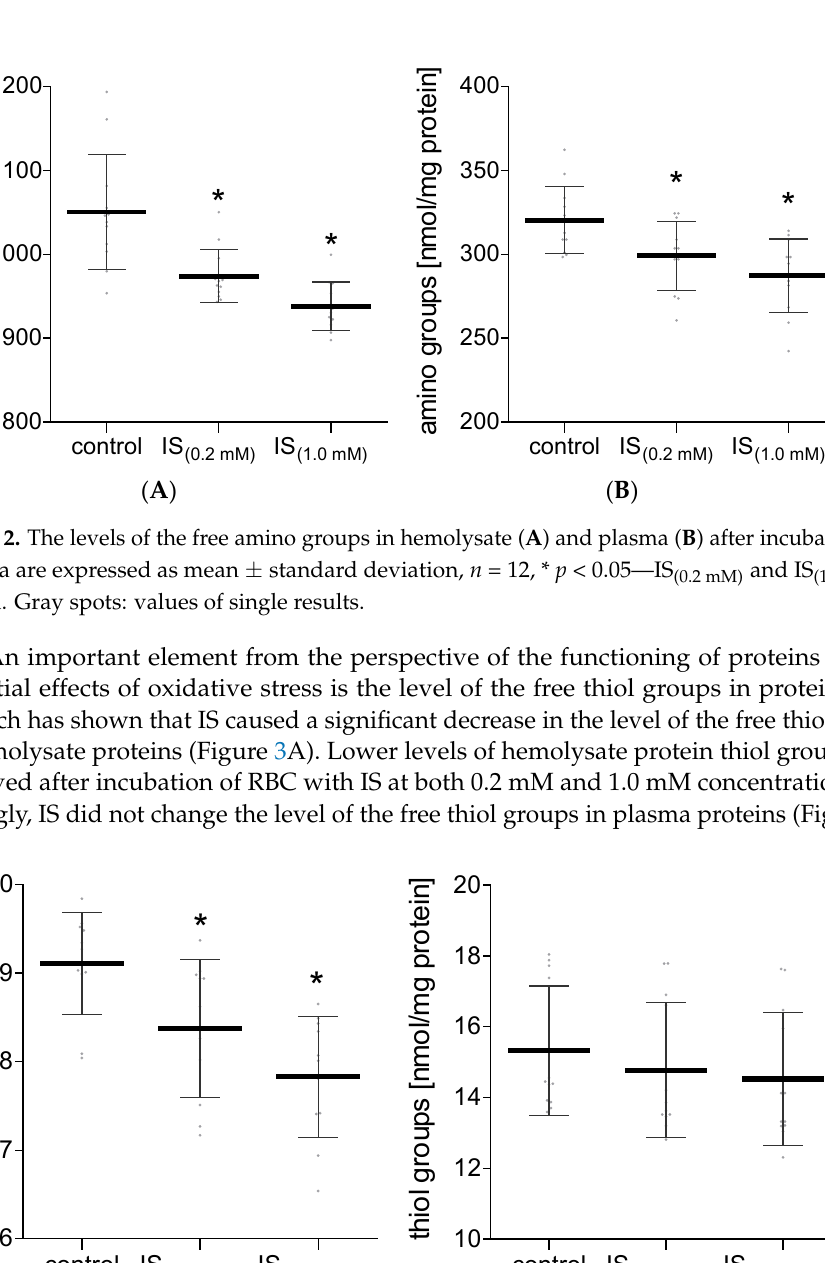
Figure 1. The levels of the carbonyl compound in hemolysate ( A ) and plasma ( B ) after incubation with IS. Data are expressed as mean ± standard deviation, n = 12. Gray spots: values of single results.